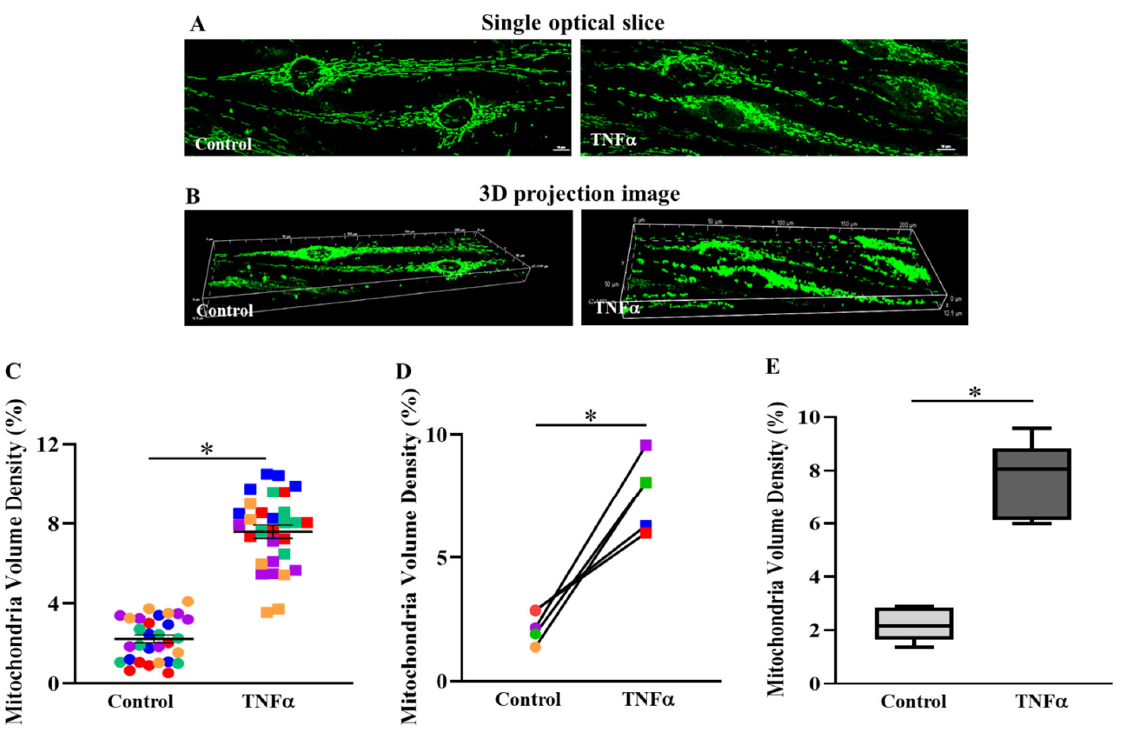
Figure 3. TNF α increases mitochondrial volume density in hASM cells. Mitochondria in hASM cells were labeled with MitoTracker Green and imaged in 3D using confocal microscopy ( A ). Representative confocal optical slice (0.5 mm) image of labeled mitochondria in hASM cells. ( B ). Three-dimensional projection image of a Z-series of optical slices from which mitochondrial morphology and volume density were determined in hASM cells (scale bar = 10 µ m), ( C ). Scatter plot showing mitochondrial volume densities of hASM cells from five patient samples ( n = 30 hASM cells per group). Note that mitochondrial volume densities were significantly higher in TNF α -treated (20 ng/mL for 6 h) hASM cells compared to untreated control cells. Data are presented as mean ± SEM. Each color represents results from one patient’s bronchial sample, with squares representing TNF α‐ treated hASM cells and circles representing untreated controls. The effect of TNF α treatment on mitochondrial volume density in individual hASM cells was based on statistical analysis (one ‐ way ANOVA for repeated measures) of mitochondrial volume densities of six hASM cells per treatment group (TNF α‐ treated or untreated) from five bronchial samples (patients) using a (* p < 0.05; n = 30). ( D ). Each symbol represents the mean mitochondrial volume density of six hASM cells from each patient with lines showing the change in mitochondrial volume density induced by TNF α treatment. Each color represents results from one patient, with squares representing TNF α‐ treated hASM cells and circles representing untreated controls (* p < 0.05). ( E ). Box ‐ whisker plot showing the median and minimum to maximum distribution of mitochondrial volume densities summarizing results from all five patients (* p < 0.05).